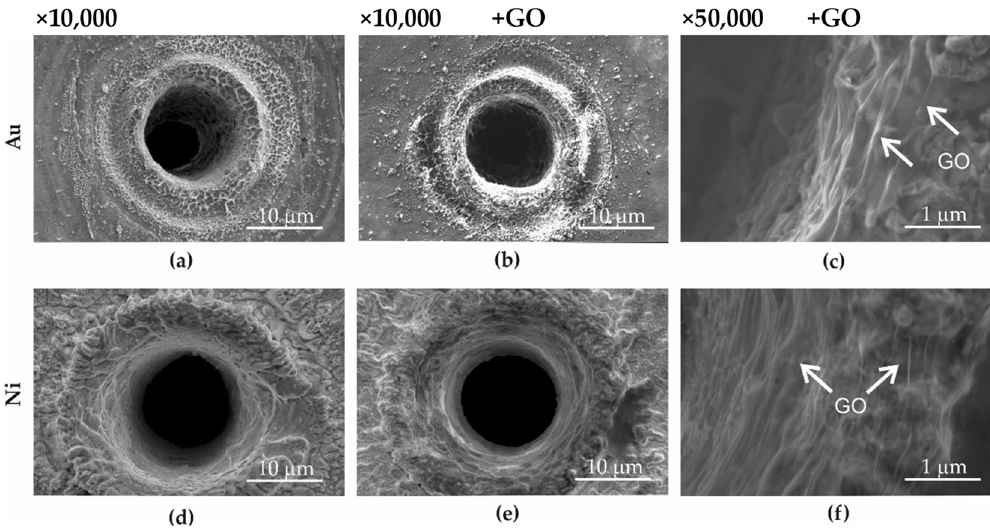
Figure 1. SEM image of the sieves: Au ( a ), Au + GO ( b , c ), Ni ( d ) i Ni + GO ( e , f ).